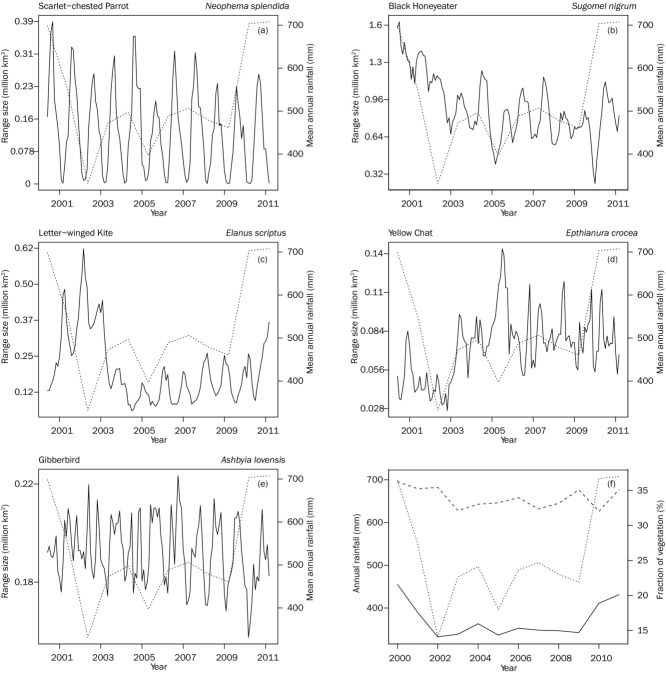
Examples of temporal dynamics in geographic range size for birds in arid Australia: (a) Scarlet-chested Parrot, (b) Black Honeyeater, (c) Letter-winged Kite, (d) Yellow Chat, (e) Gibberbird (dotted lines, mean annual rainfall for Australia for the period). (f) Mean annual rainfall (dotted line) relative to mean annual fraction of photosynthetic vegetation (solid line) and mean annual fraction of non-photosynthetic vegetation (dashed line) across Australia from 2000 to 2011.